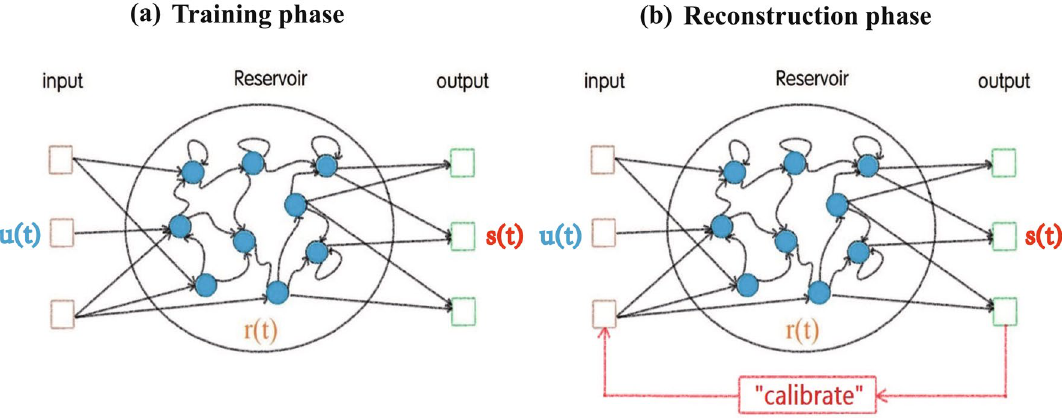
Figure 1. The calculation of the “calibrated” reservoir computing consists of the training phase and the reconstruction phase. ( a ) In the training phase, the input u ( t ) and the output s ( t ) are known, then the W out is calculated. ( b ) In the reconstruction phase, the biggest difference between our model and the classical reservoir computing is that the output s ( t ) is calibrated by the partial actual variables to reconstruct the unmeasured variables